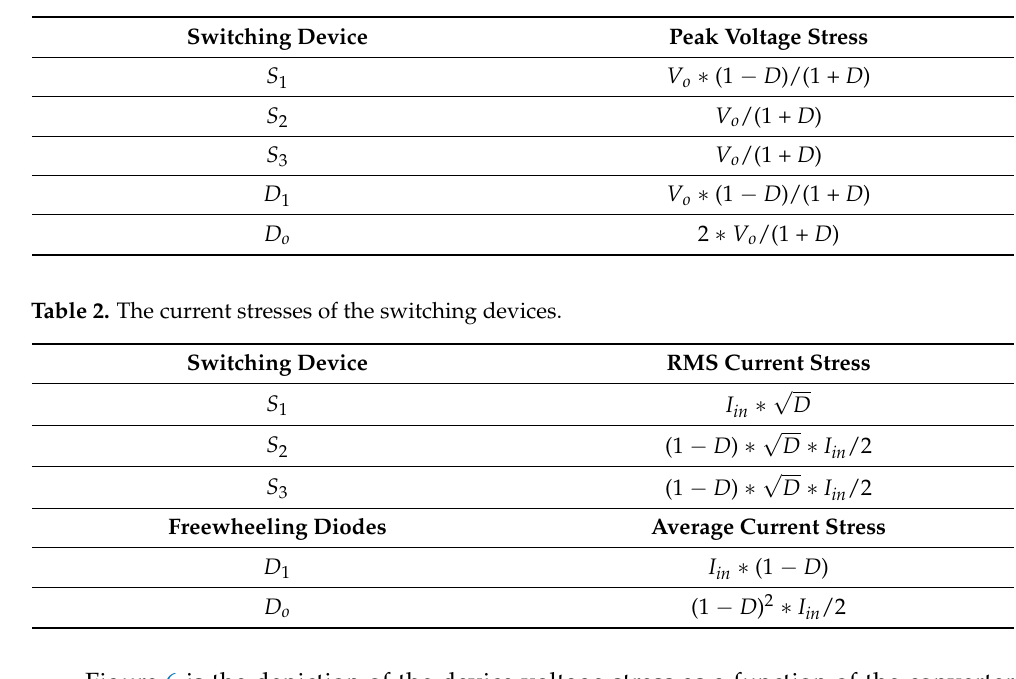
Table 1. The voltage stresses of the switching devices.